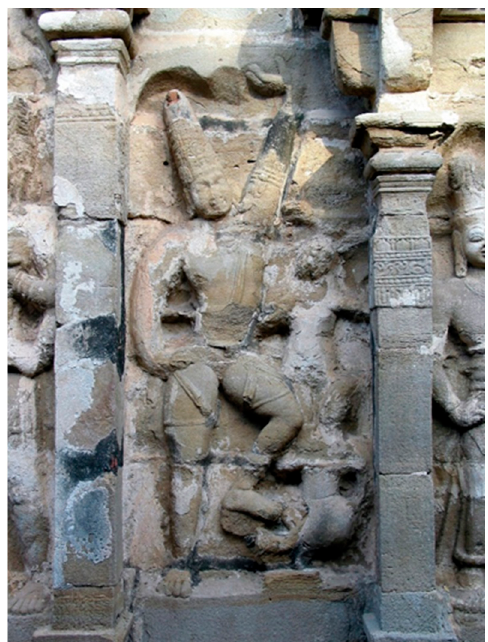
Figure 14. Govardhanadhara, beginning of the eighth century. Eastern wall, Vaiku ṇṭ ha Perum ā ḷ , K ā ñc ī puram, Tamil Nadu.